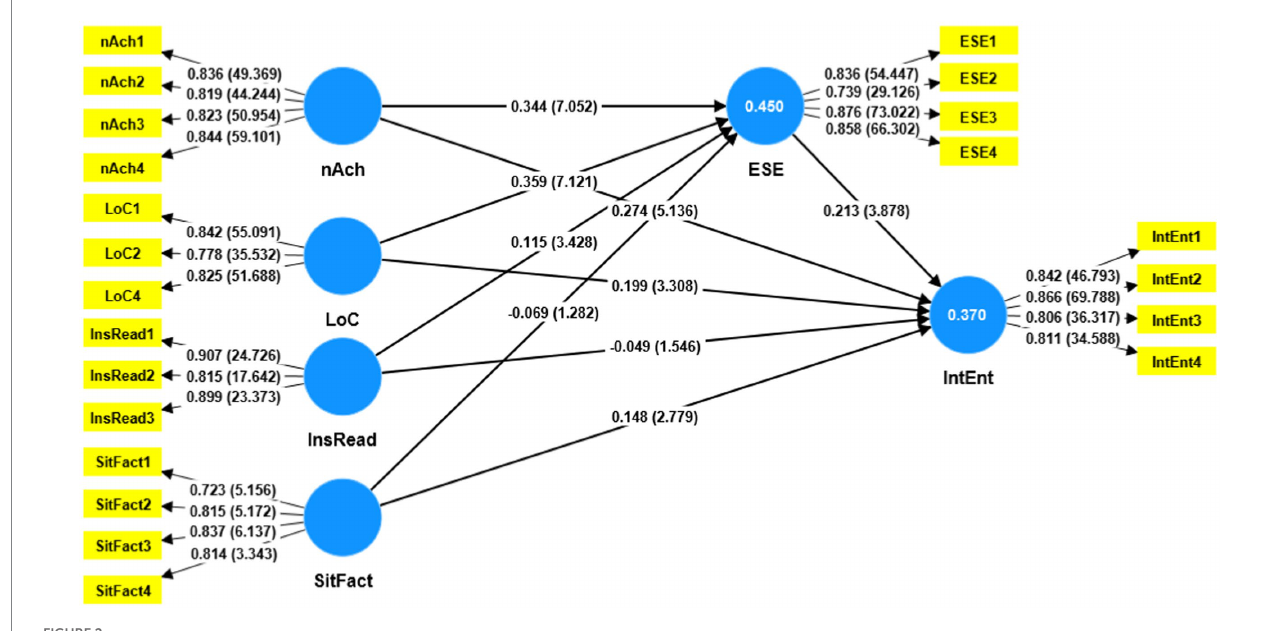
FIGURE 2 Structural model.